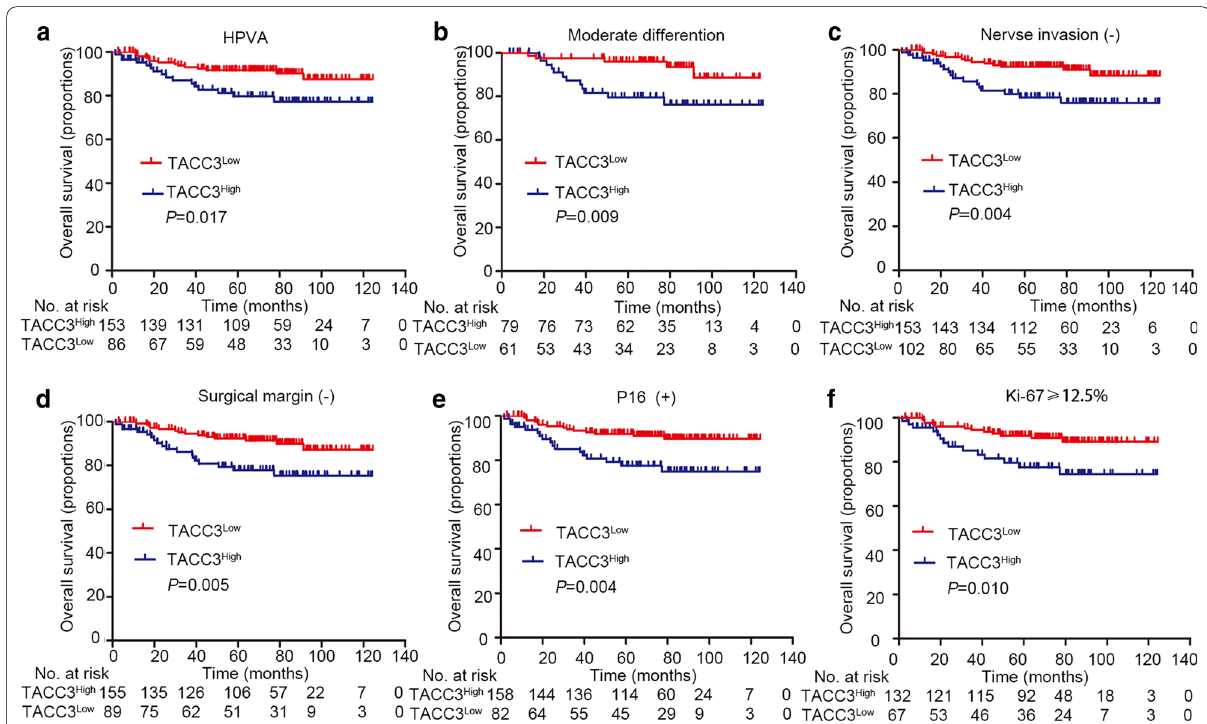
Fig. 4 Stratified analysis of TACC3 expression related to overall survival. Correlations between TACC3 expression and overall survival in the indicated